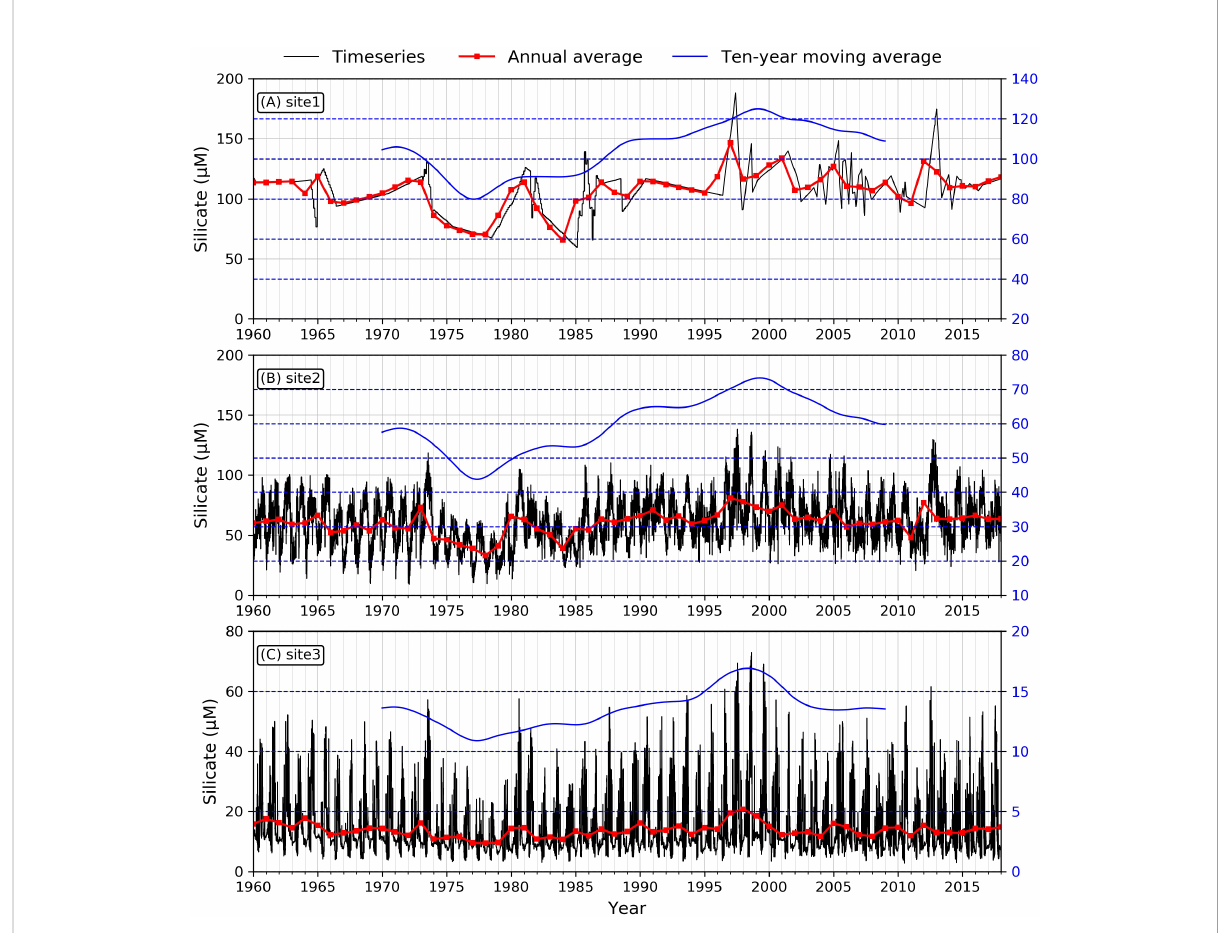
FIGURE 5 Modeled time series of silicate concentration at the three sites. ( A : site1, B : site2, C : site3). Black lines demonstrate the daily averaged silicate concentration, red lines are annual averaged values, and blue lines indicate ten-year moving averaged